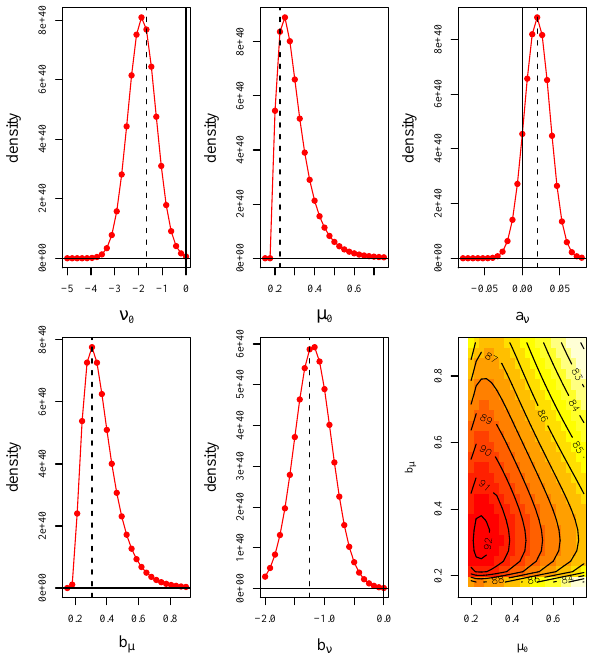
Fig. 3. Marginal posterior distributions for the model parame- ters, compared with the joint maximum posterior estimate (Table 1, dashed line) and the hypothesis of zero parameter (solid line). The posterior density map show contour curves of log π ( µ 0 ,b µ ) . This is used to obtain estimates of µ T . Note the white stripes in the lower